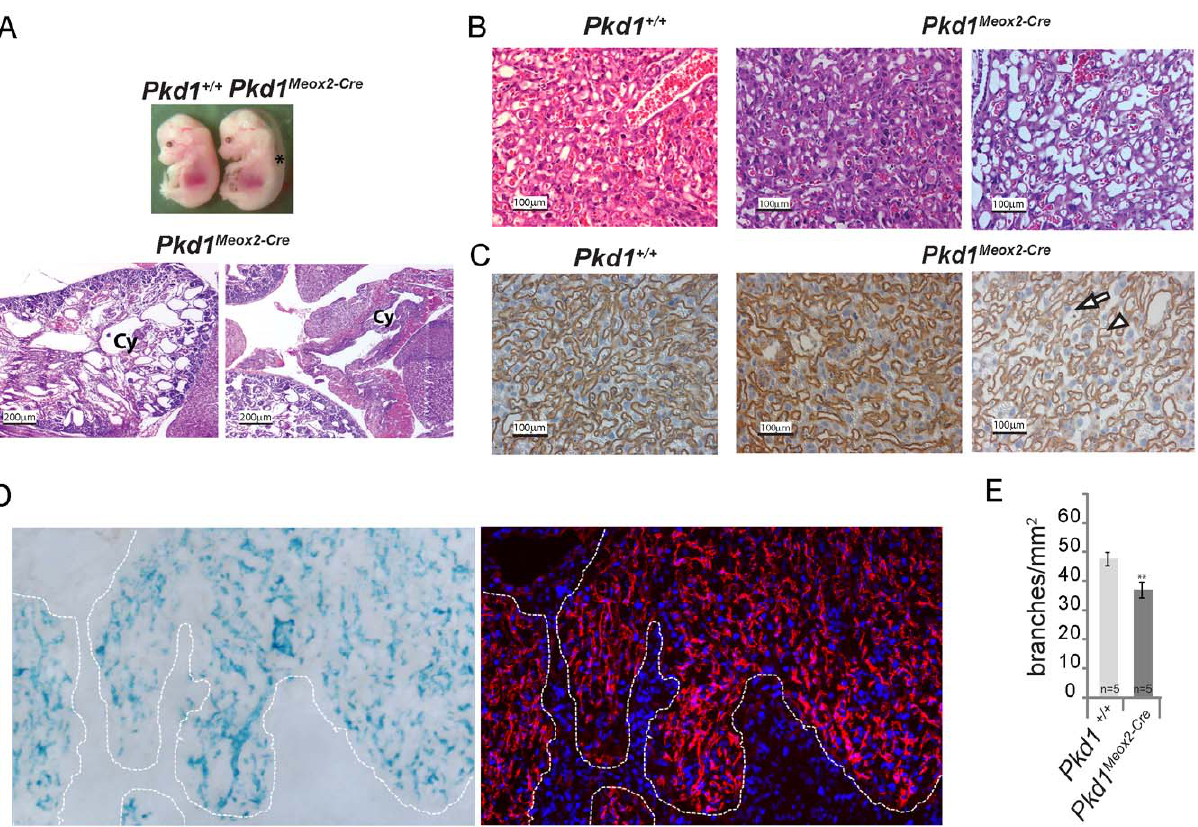
Figure 4. Conditional Inactivation of Pkd1 using Meox2 Cre recombinase. A. Conditional inactivation of Pkd1 using a Meox-2 Cre recombinase expressing mouse line results in the typical polycystin null phenotype, reflecting high activity of the recombinase in the embryo. The top panel shows the gross appearance of Pkd1 2 /cond ; Meox2-Cre + ( Pkd1 Meox2-Cre ) and Pkd1 + /cond ; Meox2-Cre 2 ( Pkd1 + / + ) neonates (top panel). Pkd1 Meox2-Cre mutants are severely edematous (*). The bottom panels show haematoxylin-eosin stained sections of cystic kidney (left) and cystic pancreas (right). ‘‘Cy’’ denotes cysts. B, C. Sections of E14.5 placentas from Pkd1 cond/ + , Meox2-Cre 2 ( Pkd1 + / + ) or Pkd1 cond/ 2 , Meox2-Cre + ( Pkd1 Meox2-Cre ) embryos stained with haematoxylin-eosin (B) or IB4 (C). Two representative examples of Pkd1 Meox2-Cre placentas show different degrees of rescue when compared with a Pkd1 + / + littermate control. The Meox-2Cre recombinase activity would be expected to spare placental trophoblasts and cells derived from extra-embryonic endoderm lineages. D. In order to determine the spatial pattern of placental Meox-2 Cre activity, frozen sections of Pkd1 cond/ 2 ; Meox2-Cre + , Rosa26R E14.5 placentas were stained with b -galactosidase (left panel) or antibodies to Pecam-1 (right panel). The dotted white line outlines the stained area. Nuclei are stained with DAPI (blue). Cre activity appears to overlap with anti-Pecam 1 staining, suggesting